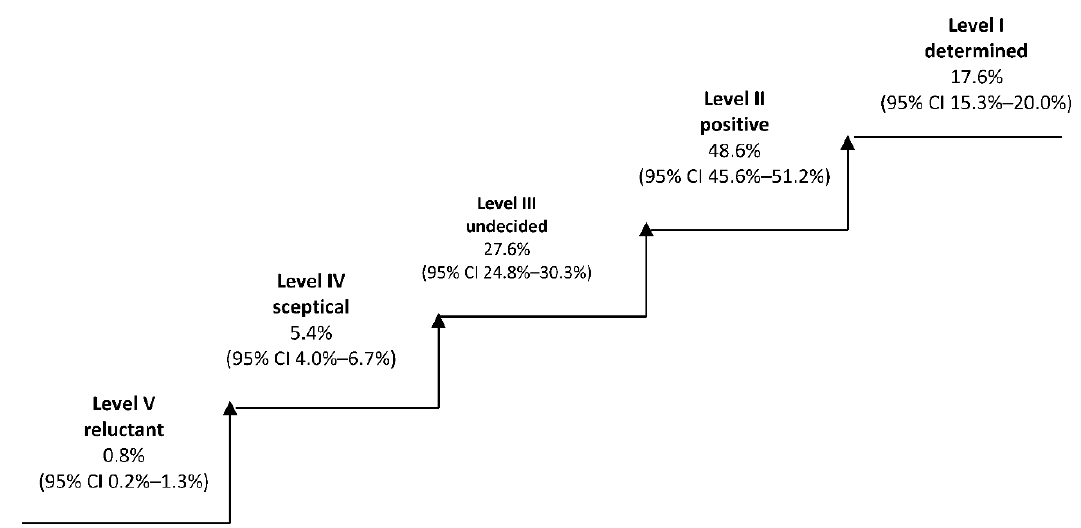
Figure 1. Respondents by level of interest in purchasing long-term care insurance (LTCI) (source: Author’s own elaboration).